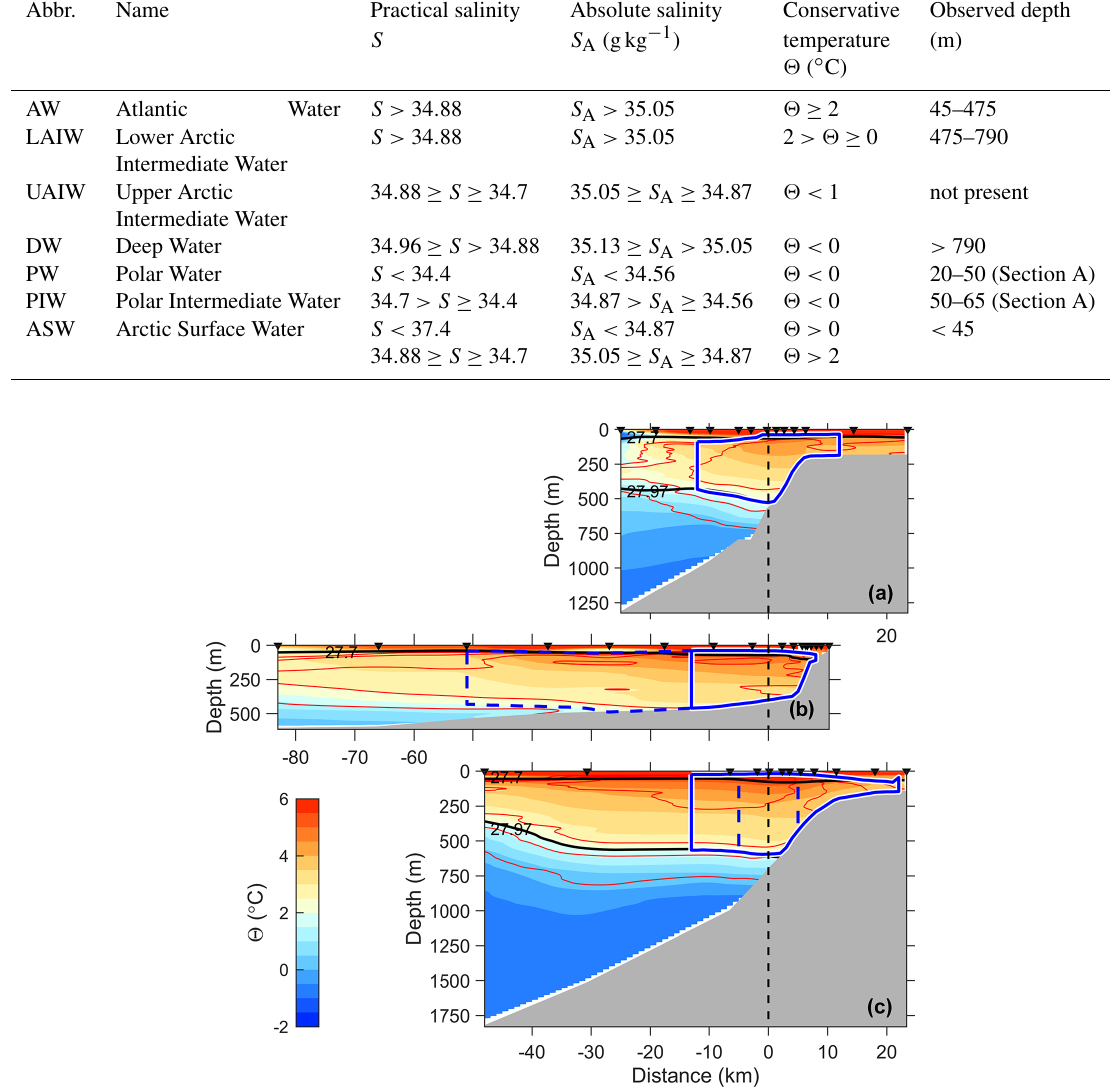
Figure 2. Distribution of conservative temperature ( (cid:50) , color) and absolute salinity ( S A , red contours in 0.05gkg − 1 intervals) along sections (a) A, (b) B and (c) C. Blue lines enclose stream tube 1 (solid) and stream tube 2 (dashed). Black lines are potential density anomaly, σ θ , of 27.7 and 27.97kgm − 3 . The horizontal distance is referenced to the core ( x = 0), and the three sections are aligned at x = 0 (vertical dashed line). Station locations are marked with black arrows at the top of each